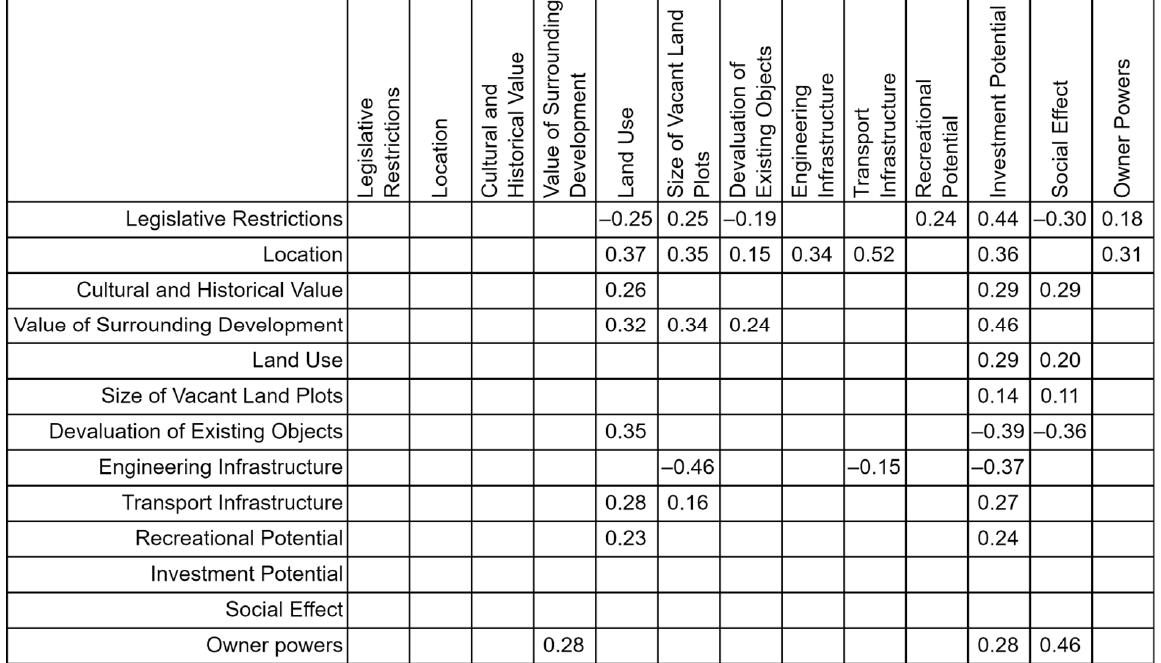
Figure 6. Adjacency matrix of study area factors.